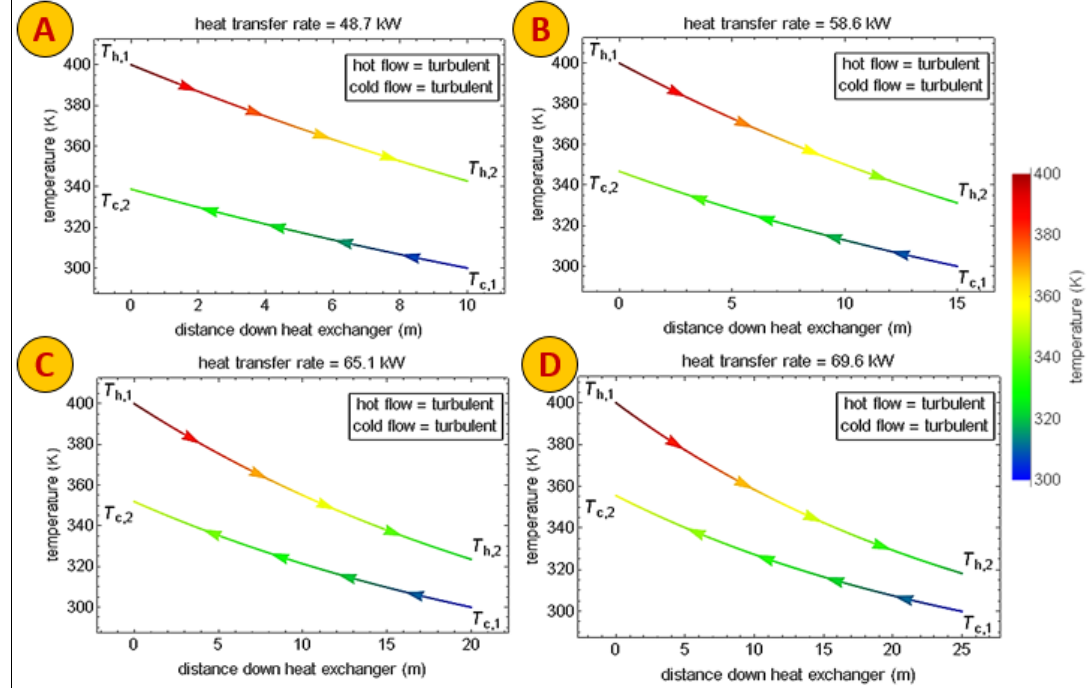
Figure 7. Counter HE temperature distribution at length of (A), 10 m (B), 15 m (C), 20 m, and (D) 25